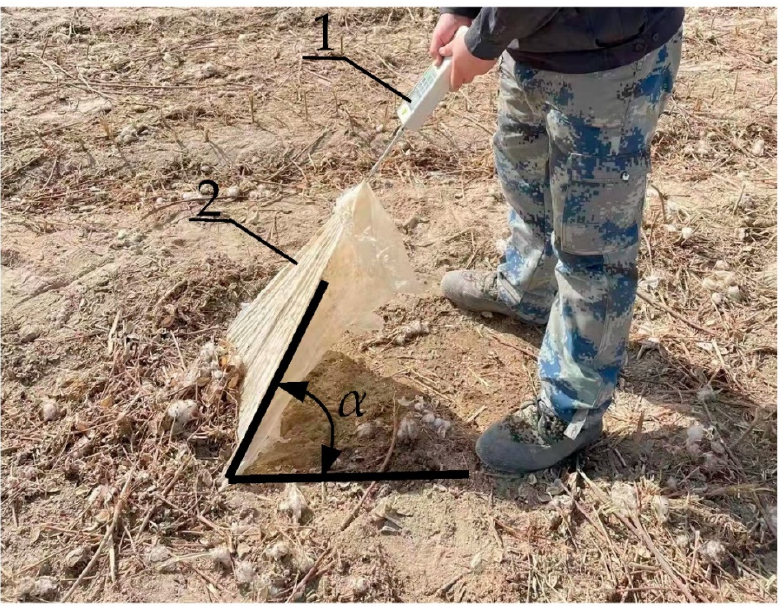
Figure 6. Test field on curl-up force in film collecting: 1—HP-50 type Digital Display Pull and Push Strength Calculator, 2—film.